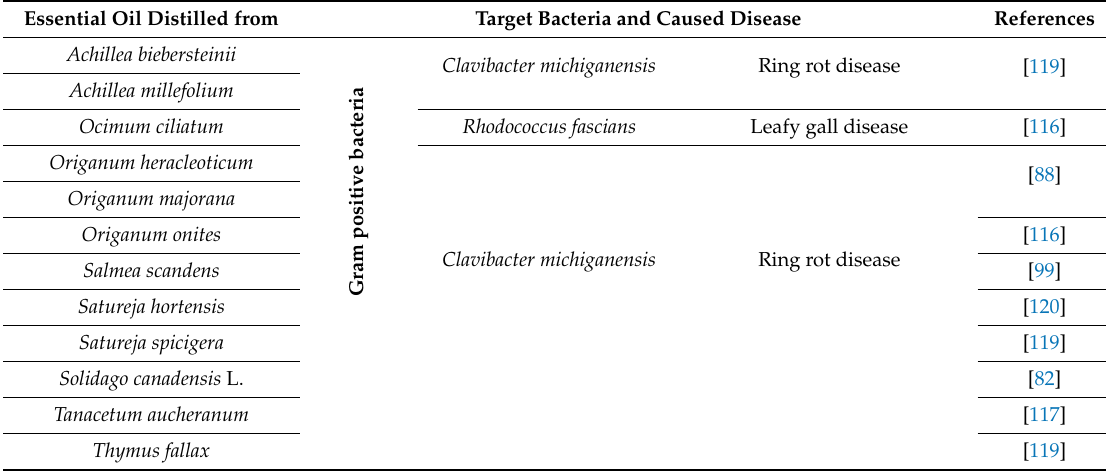
Table 2. Examples of EO acting against phytopathogenic bacteria (from 2007 to present). Essential Oil Distilled